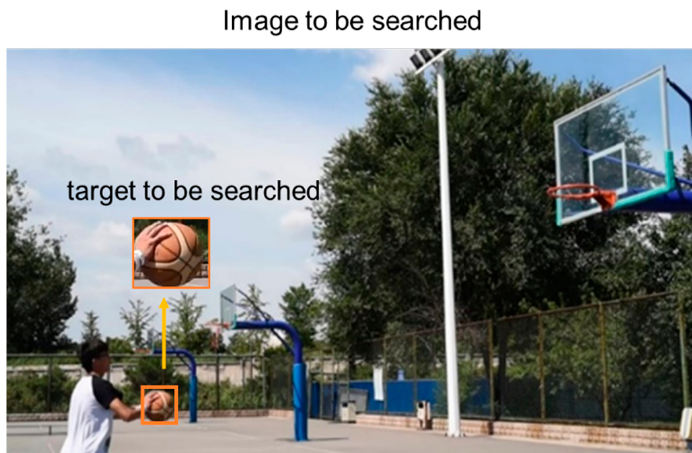
Figure 3. The searched image and the searched target.